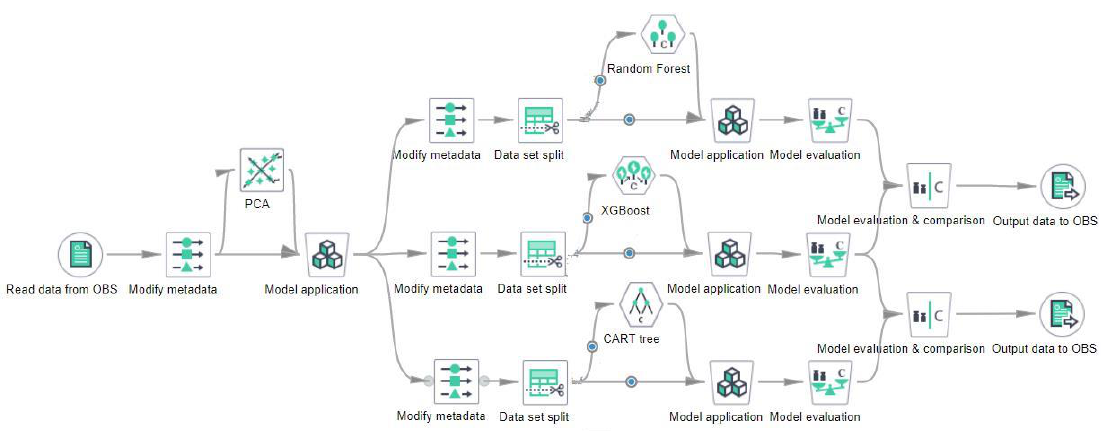
Figure 6. Model comparison analysis.